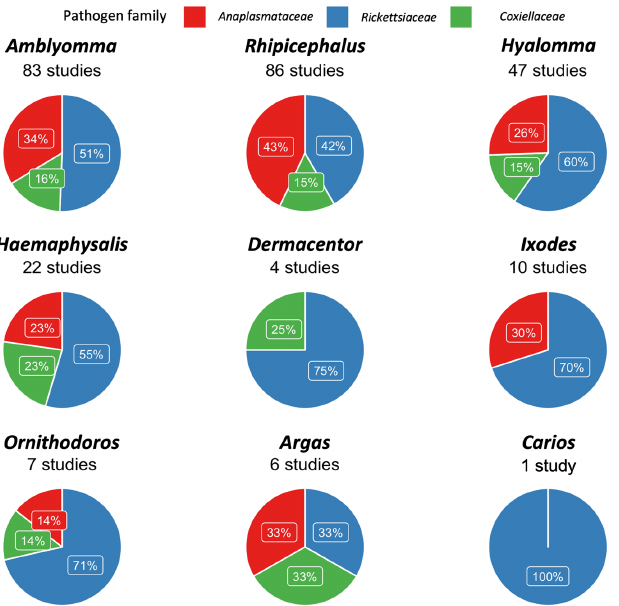
Figure 8. Relative percentage of the studies reporting infection with at least one Anaplasmataceae, Rickettsiaceae or Coxiellaceae species.